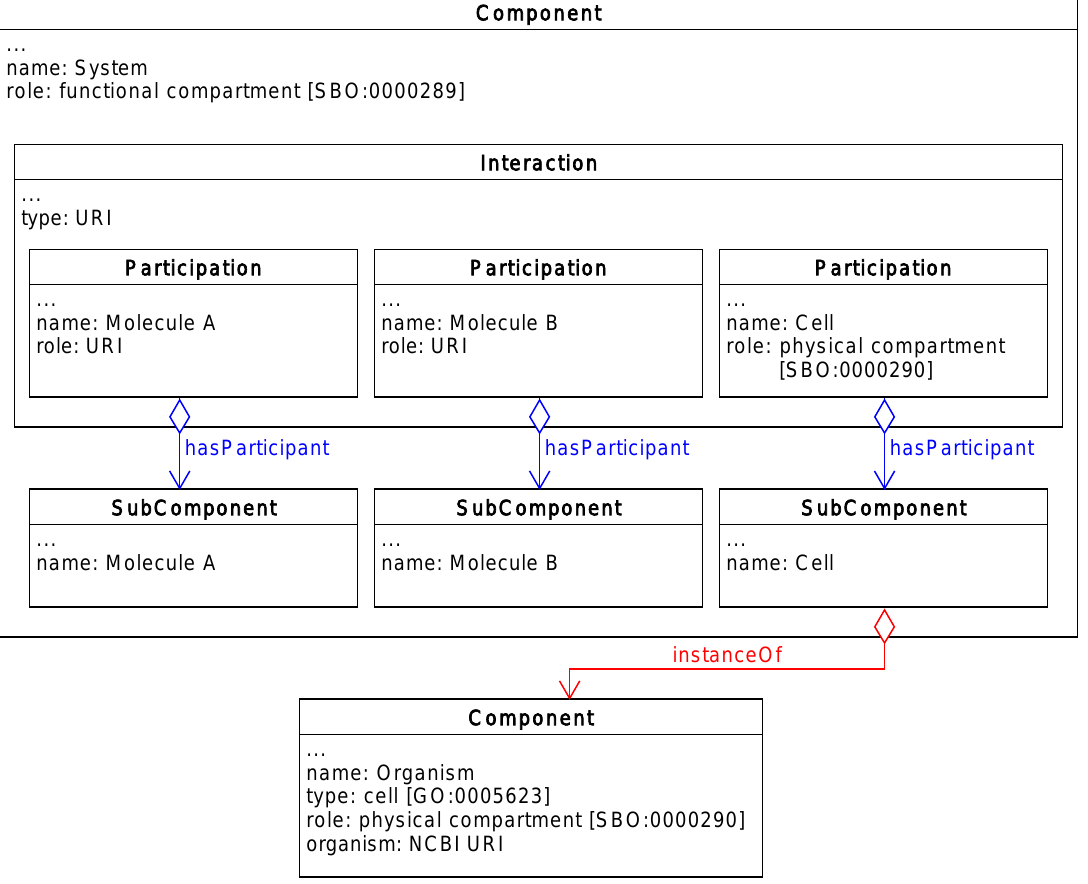
Figure 22: This is a proposed approach for capturing cell designs in SBOL. A Component annotated with a URI pointing to an entry in the NCBI Taxonomy Database is used to capture information about the cell’s strain/species. The Component has a type of “Cell” from the Gene Ontology (GO), and a role of “physical compartment”. Another Component is used to represent a system in which the cell is implemented. Entities, including the cell, are instantiated as SubComponent s, and processes are captured using the Interaction class. Processes that are contained within the cell are represented by including the cell as a participant with a role of “physical